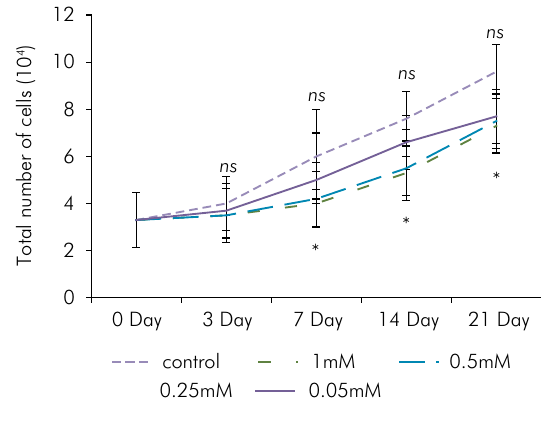
Figure 4. Effect of inorganic phosphate treatment (Pi) on the total number of cells at 3, 7, 14, and 21 days after treatment (Pi-treated). ns: non-significant intergroup differences by one-way ANOVA with alpha = 0.05; *intragroup difference by one-way ANOVA followed by the Bonferroni test compared to day 0 for all the experimental groups with alpha =